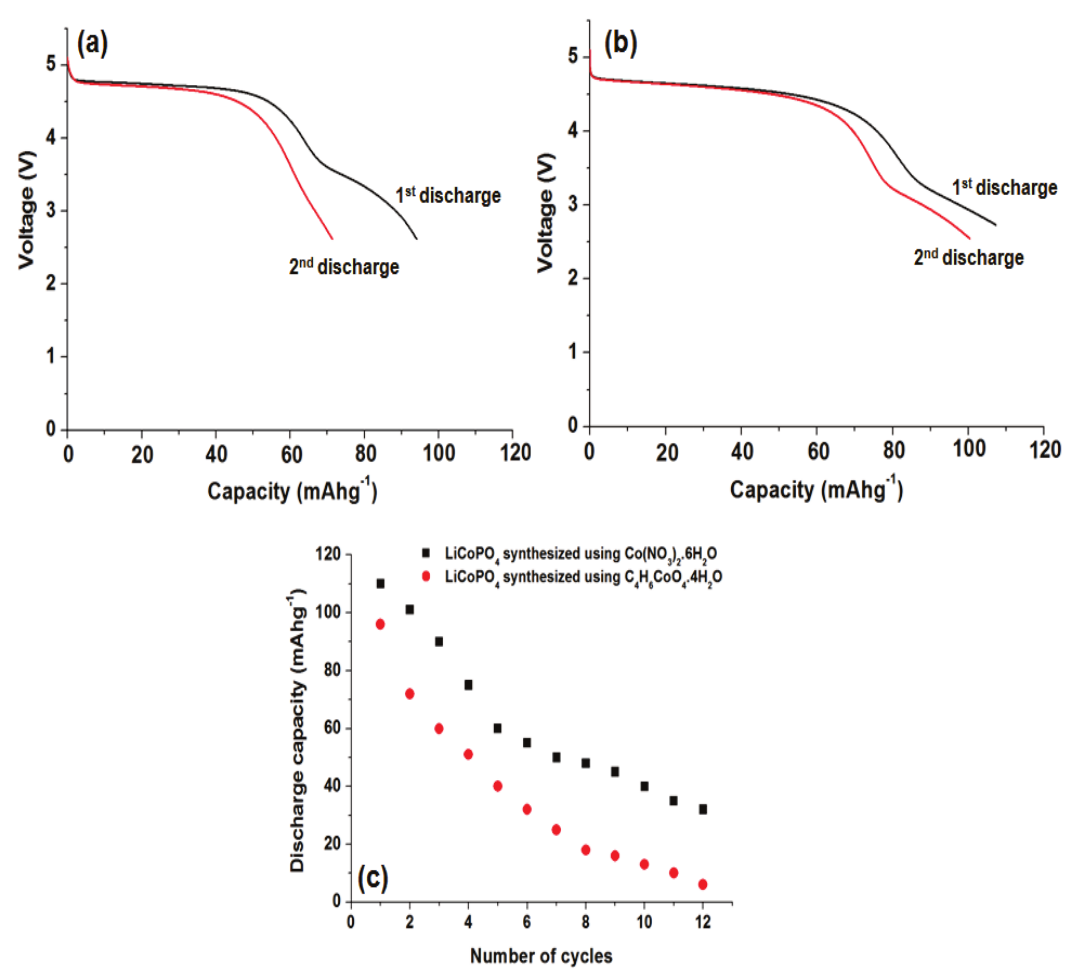
H CoO 4H O as starting materials; ( c ) cyclic 4 6 4 2